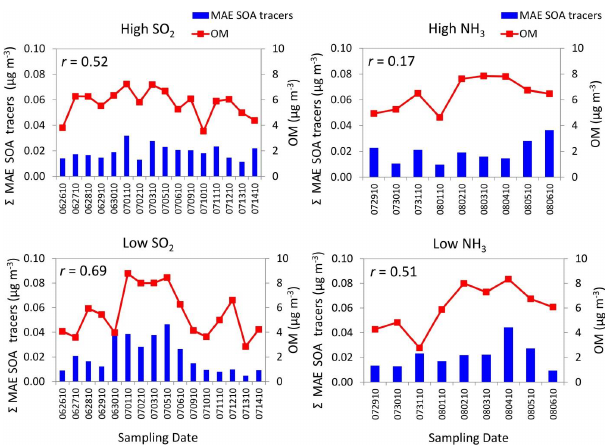
Figure 5. Temporal variations of isoprene high-NO x SOA tracers and OM. 684 Fig. 5. Temporal variations of isoprene high-NO x SOA tracers and OM.